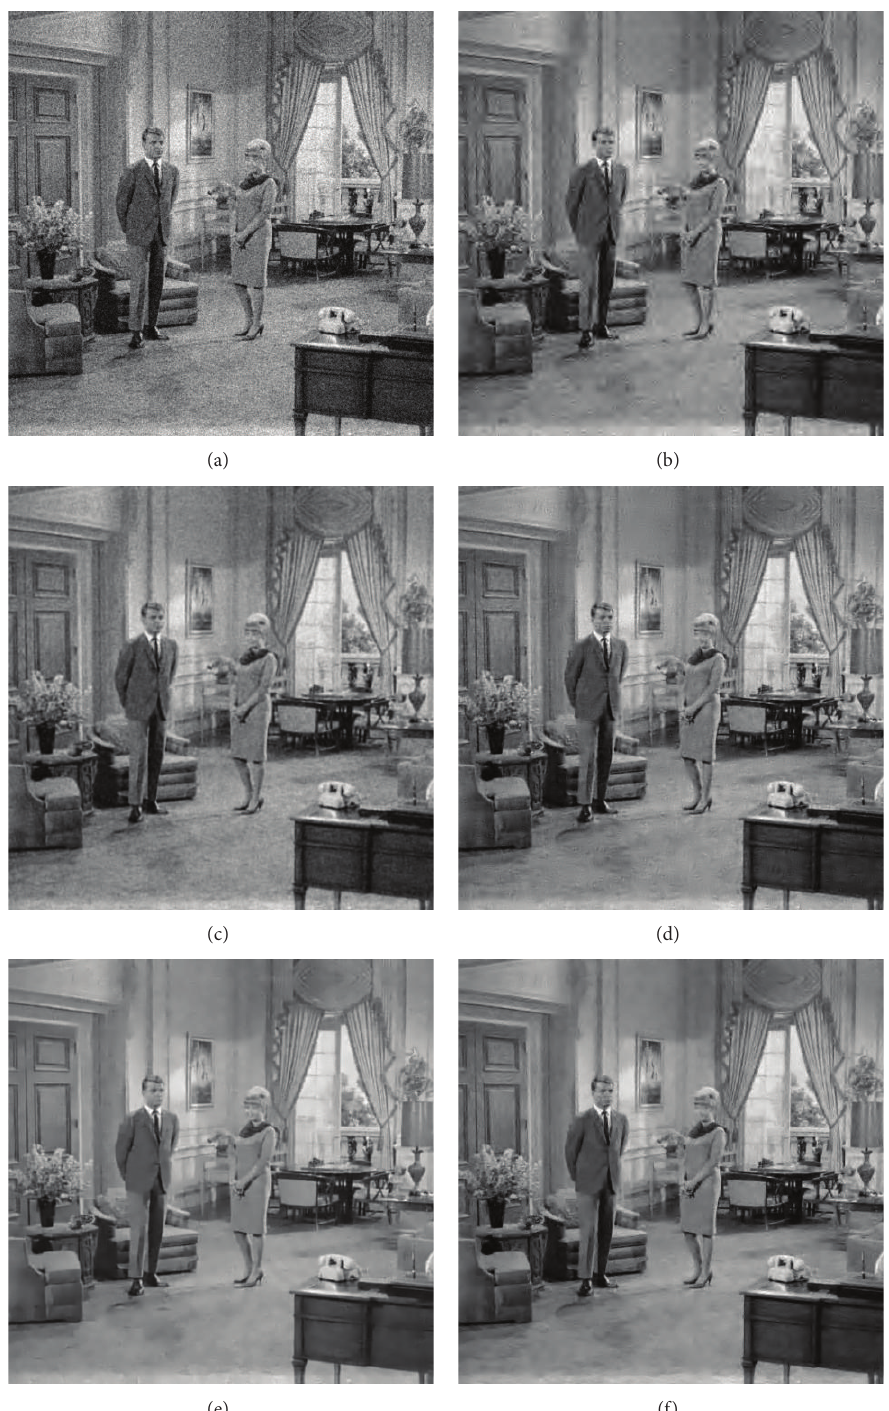
Figure 3: Comparison of the denoised images obtained from different denoising algorithms on test image Couple with 𝜎 𝑛 = 20 . (a) Noisy image. (b) Denoised image using SureShrink. (c) Denoised image using BayesShrink. (d) Denoised image using BLS-GSM. (e) Denoised image using K-SVD. (f) Denoised image using the proposed